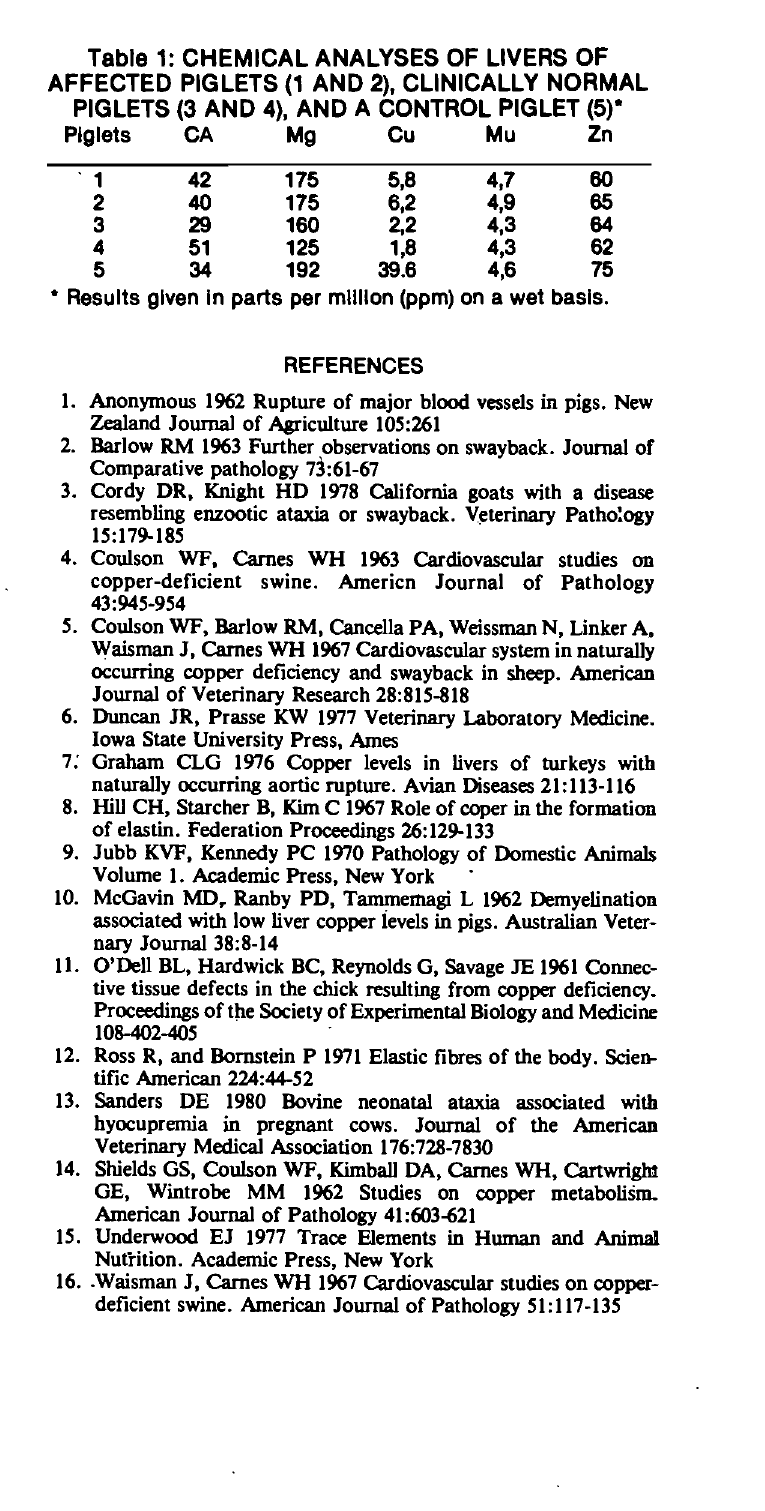
Table 1: CHEMICAL ANALYSES OF LIVERS OF AFFECTED PIGLETS (1 AND 2), CLINICALLY